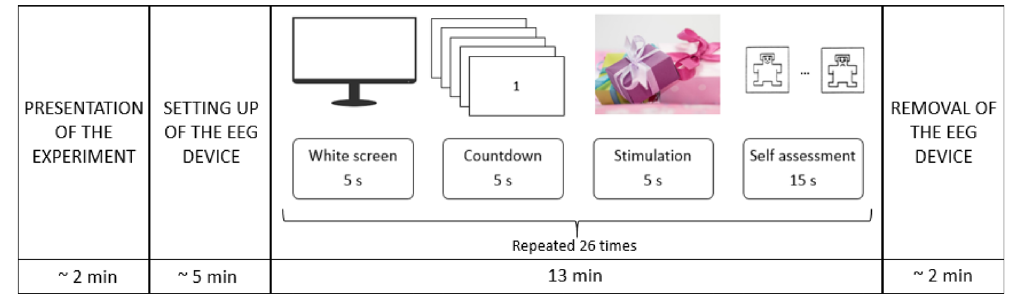
Figure 2. Experimental